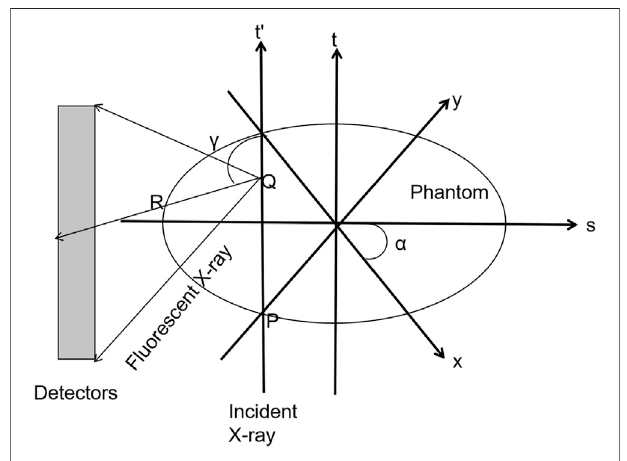
FIGURE 1 | Geometry of